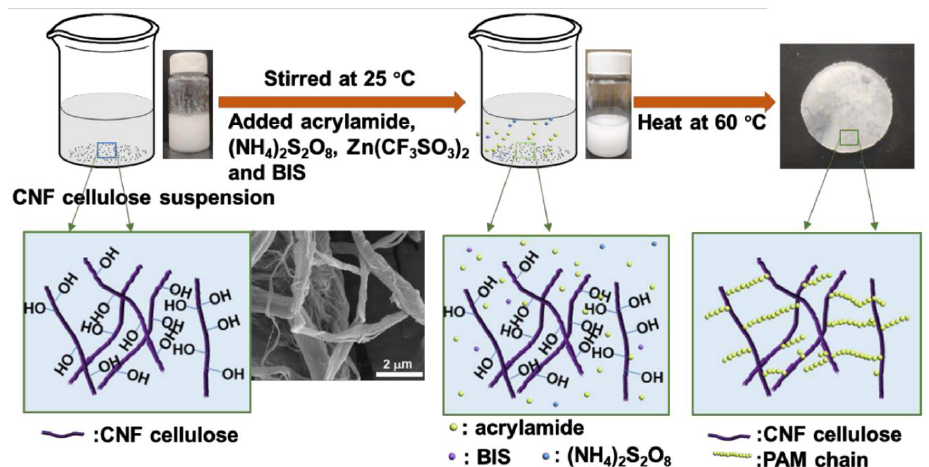
Figure 4. Schematic of the synthesis route to form solid-state electrolytes by grafting PAM on cellulose